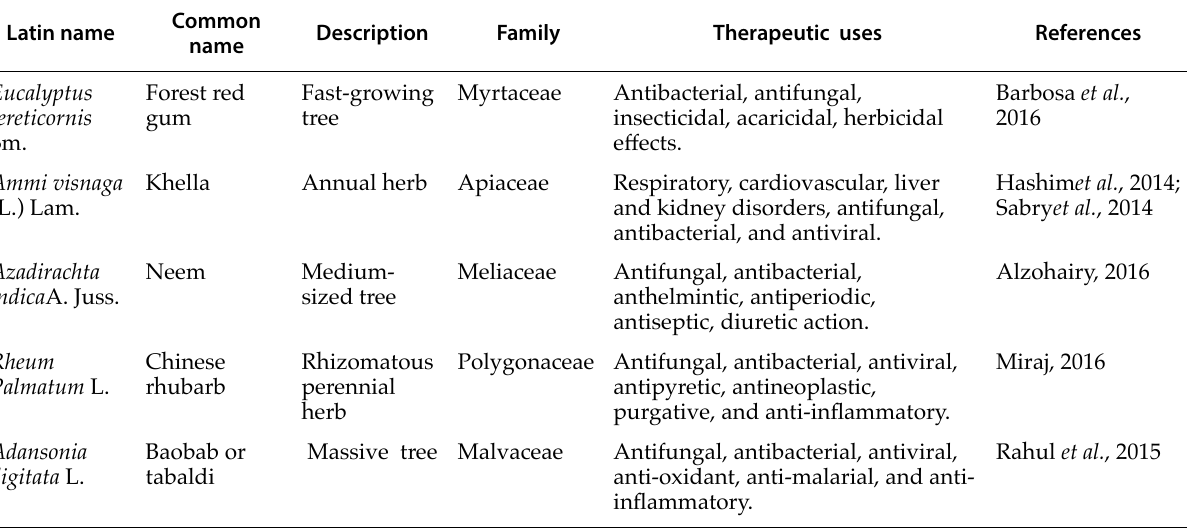
Table 1. Medicinal plants tested in the present